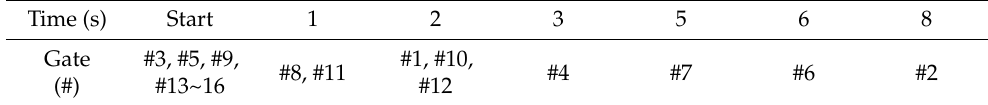
Table 1. Sequence of the filling